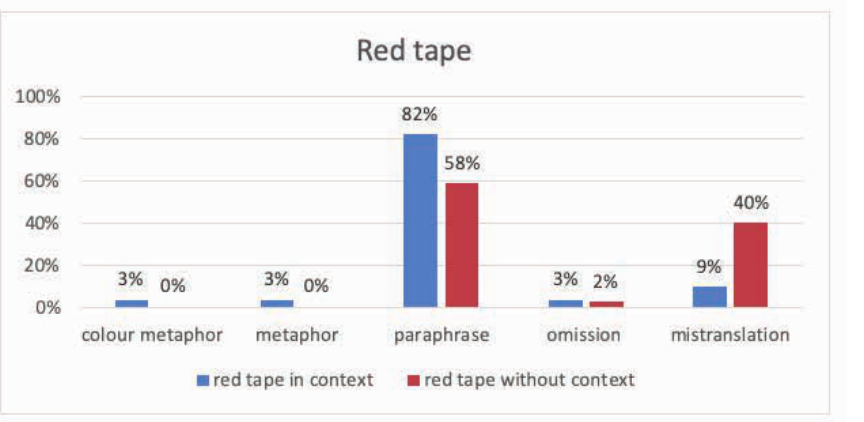
Figure 4: Translation strategies used for translating the colour metaphor red tape in context and without context.